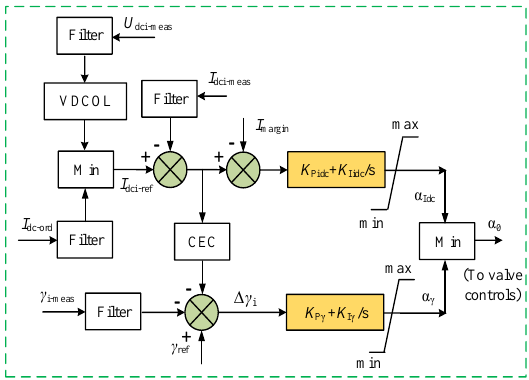
Figure 2. Block diagram of the inverter ‘side control of the UHVDC-HCS system.